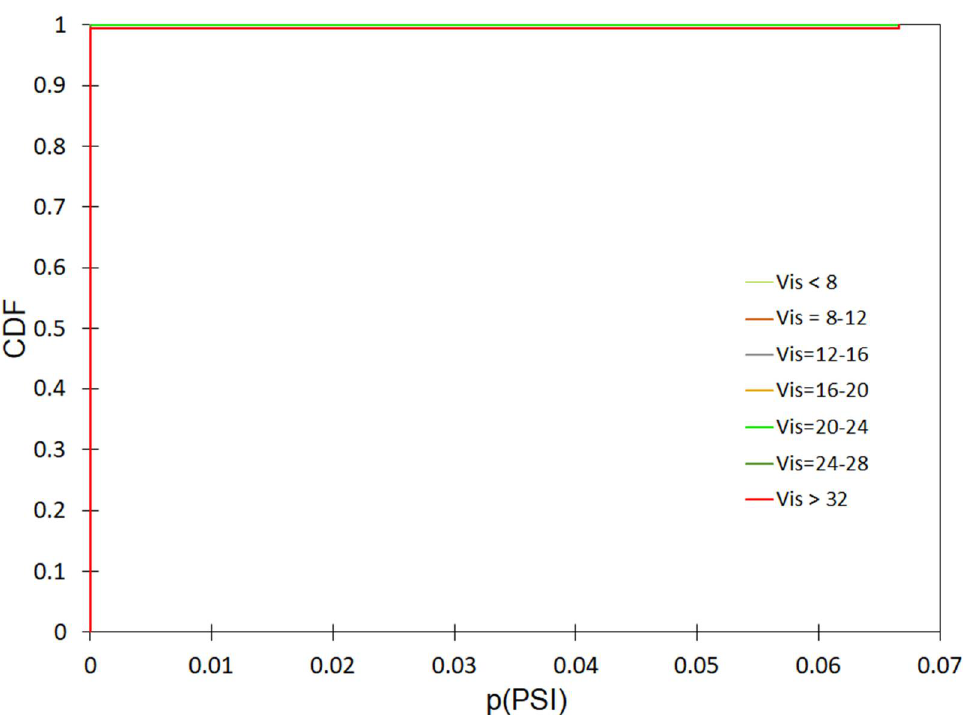
Figure A21. Effect of visibility on the incidence of mean summer mortality for rainy days.